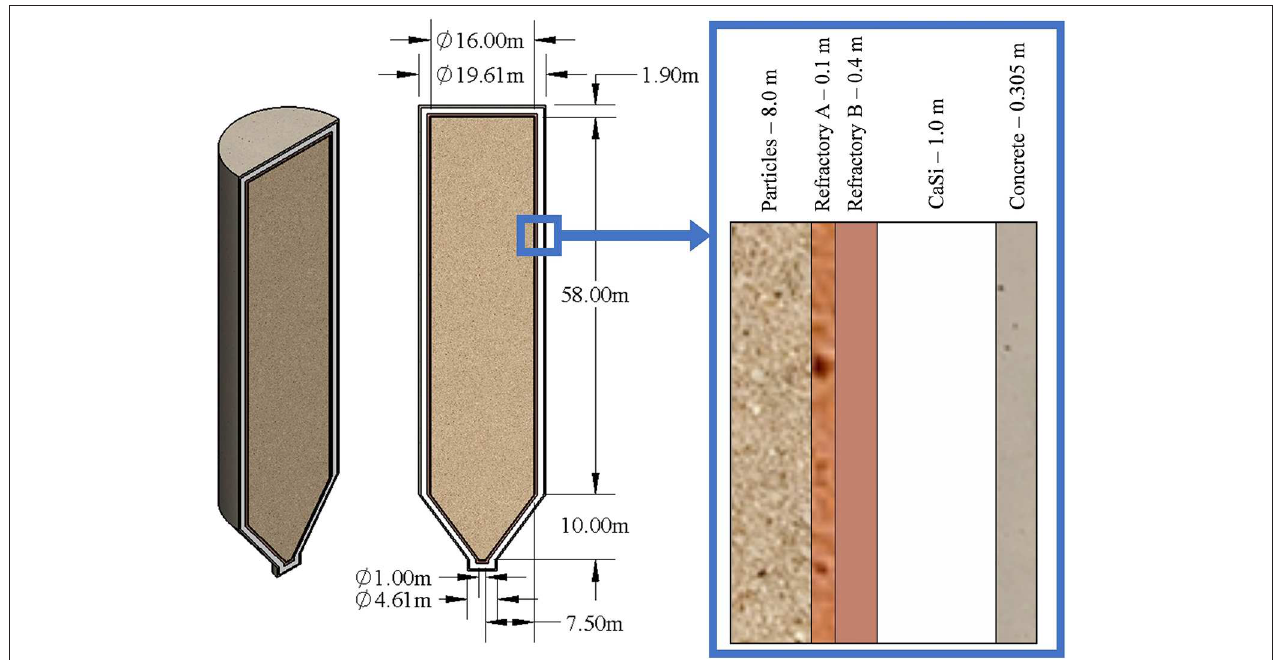
FIGURE 2 | The full 3D silo geometry used with global dimensions and insulation material choices with the dimensions highlighted on the right. Insulation material dimensions shown are uniform thicknesses while the particle dimension shown is the particle domain’s radius.